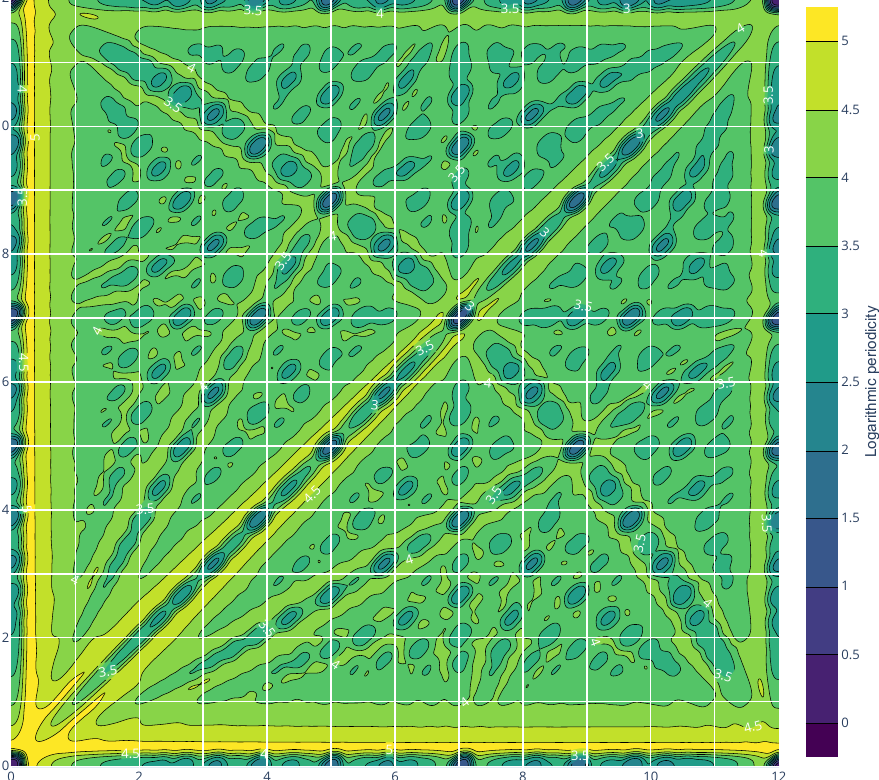
[ 0,12 ] using JND = 18 cent smoothed 3